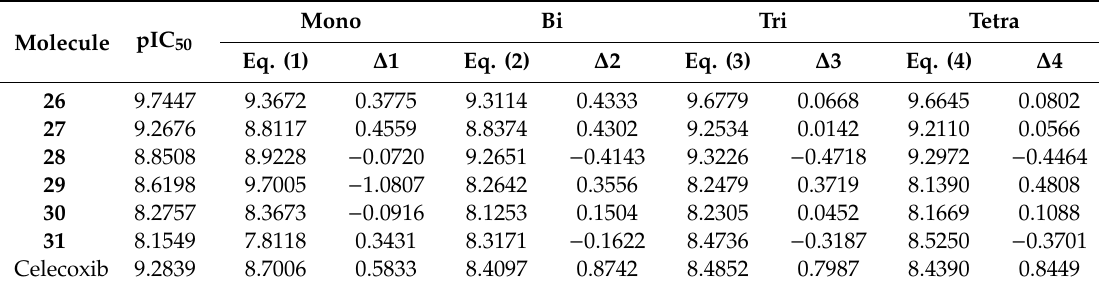
Table 4. External validation set.